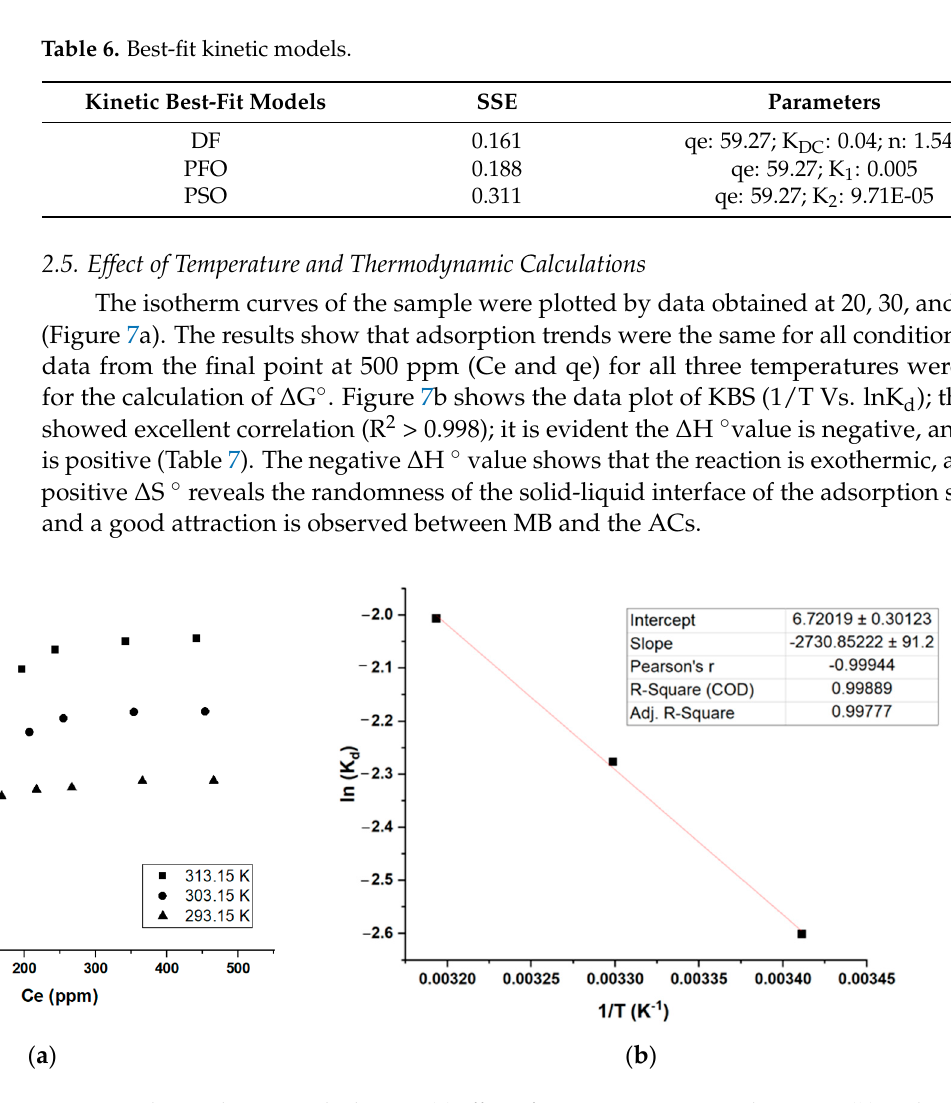
Figure 6. MB adsorption capacity (qt) Vs. time; ( a ) contact time trend, ( b ) best-fit kinetic models. Table 6. Best-fit kinetic models.